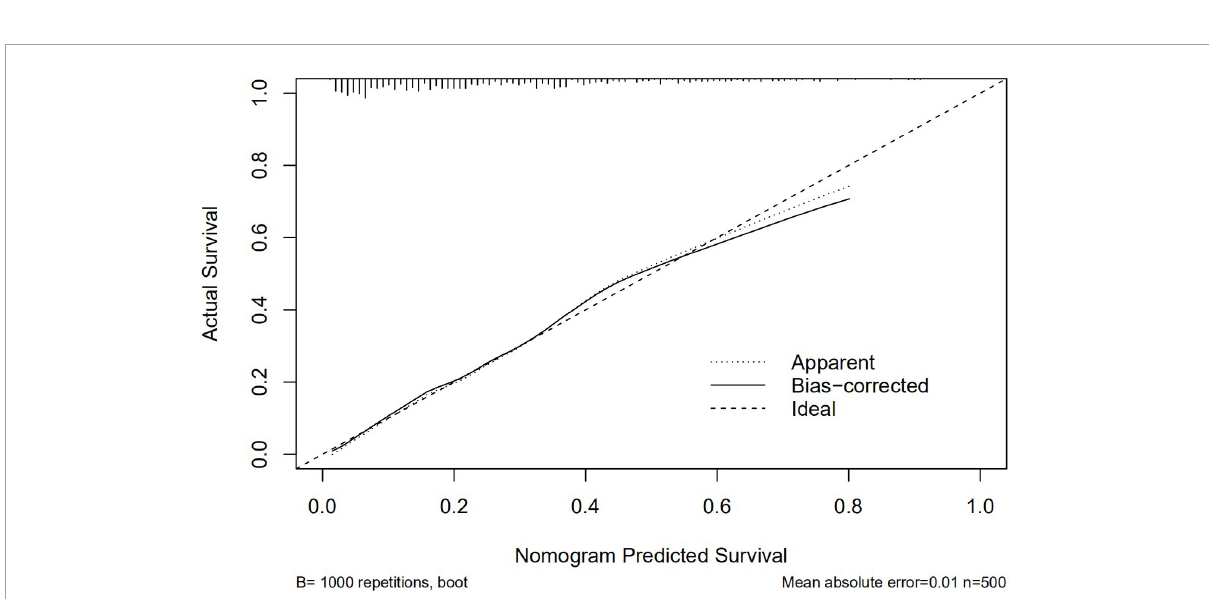
FIGURE5 Calibration curves of the predictive nomogram. The x-axis and the y-axis represent the predicted probability and the actual probability of delayed post-polypectomy bleeding,